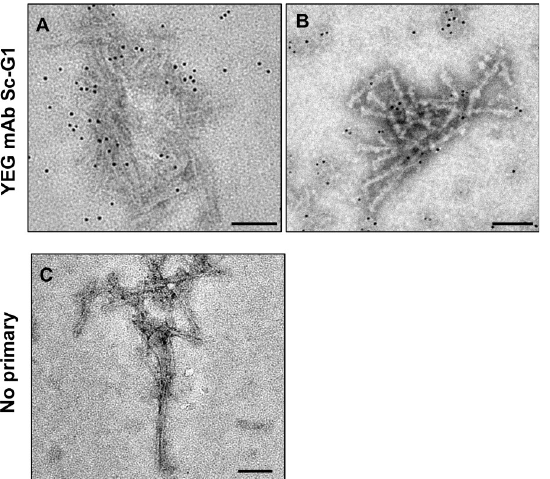
Fig 12. Immunogold labeling of purified L-type BSE fibrils with a conformation-dependent monoclonal antibody. ( A & B ) Represents samples labeled with the YEG mAb Sc-G1 monoclonal antibody, which recognizes a discontinuous epitope on native PrP Sc only. The monoclonal antibody was detected with a secondary antibody coupled to 6 nm gold particles ( C ) Control grid that underwent the same treatment except for the omission of the primary antibody, showing no gold labeling. Scale bar = 100 nm.